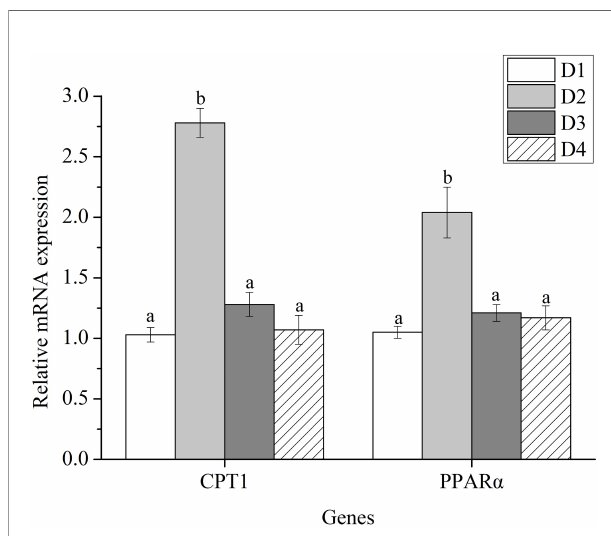
FIGURE 4 | The expression pro fi les of lipolysis-related genes in the liver of Trachinotus ovatus fed experimental diets for 56 days. Different superscript letters in the same row means the signi fi cant difference at P < 0.05. CPT1, carnitine palmitoyl transferase 1; PPAR a , peroxisome proliferator-activated